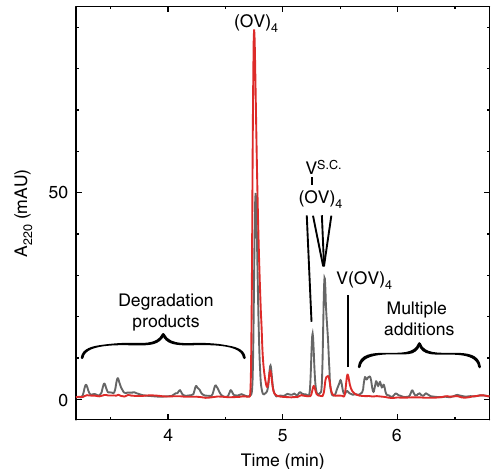
Fig. 6 Hydrolytic resistance of the (OV) 4 /V(DV) 4 amyloid. Reverse-phase HPLC chromatograms of the addition reactions with valine carried out at 90 °C for 6 h. The reactions with just the substrate (OV) 4 are the black traces and those with the amyloid (OV) 4 /V(DV) 4 are the red ones. The (OV) 4 concentration was 100 μ M, the V(DV) 4 concentration was 120 μ M and valine concentration was 200 μ